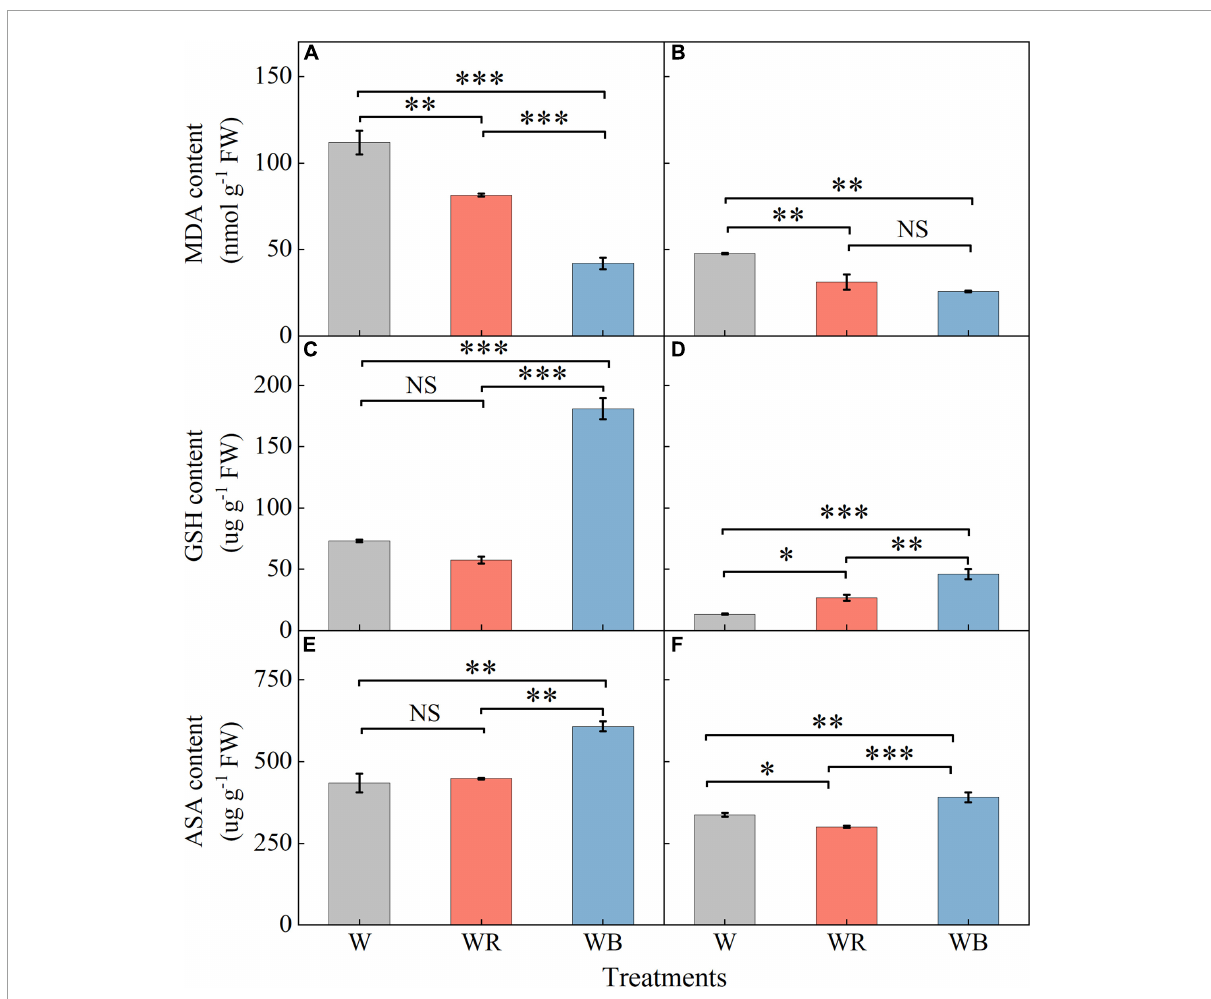
FIGURE5 The contents of malondialdehyde, glutathione and ascorbic acid in extracts of wheat seedlings leaves (A,C,E) and stems (B,D,F) under different treatments. Values represent the mean ± SE ( n = 3). The symbols ∗ , ∗∗ and ∗∗∗ indicate significance at the 0.05, 0.01, and 0.001 levels, respectively. NS, not significant, according to the Duncan’s